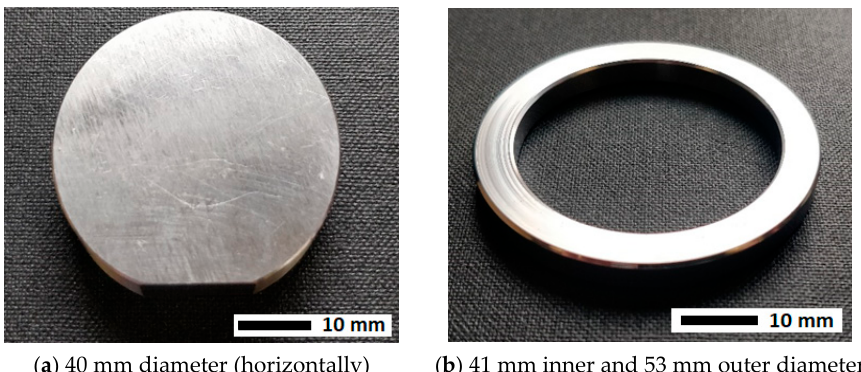
Figure 1. ( a ) Example laboratory test part used for process development; ( b ) Example part for the driveshaft assembly application.